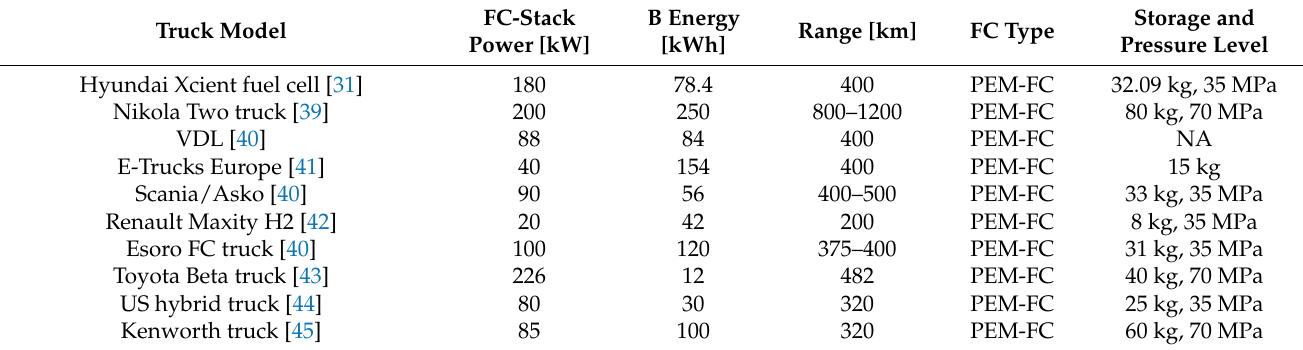
Table 3. Main characteristics of fuel cell